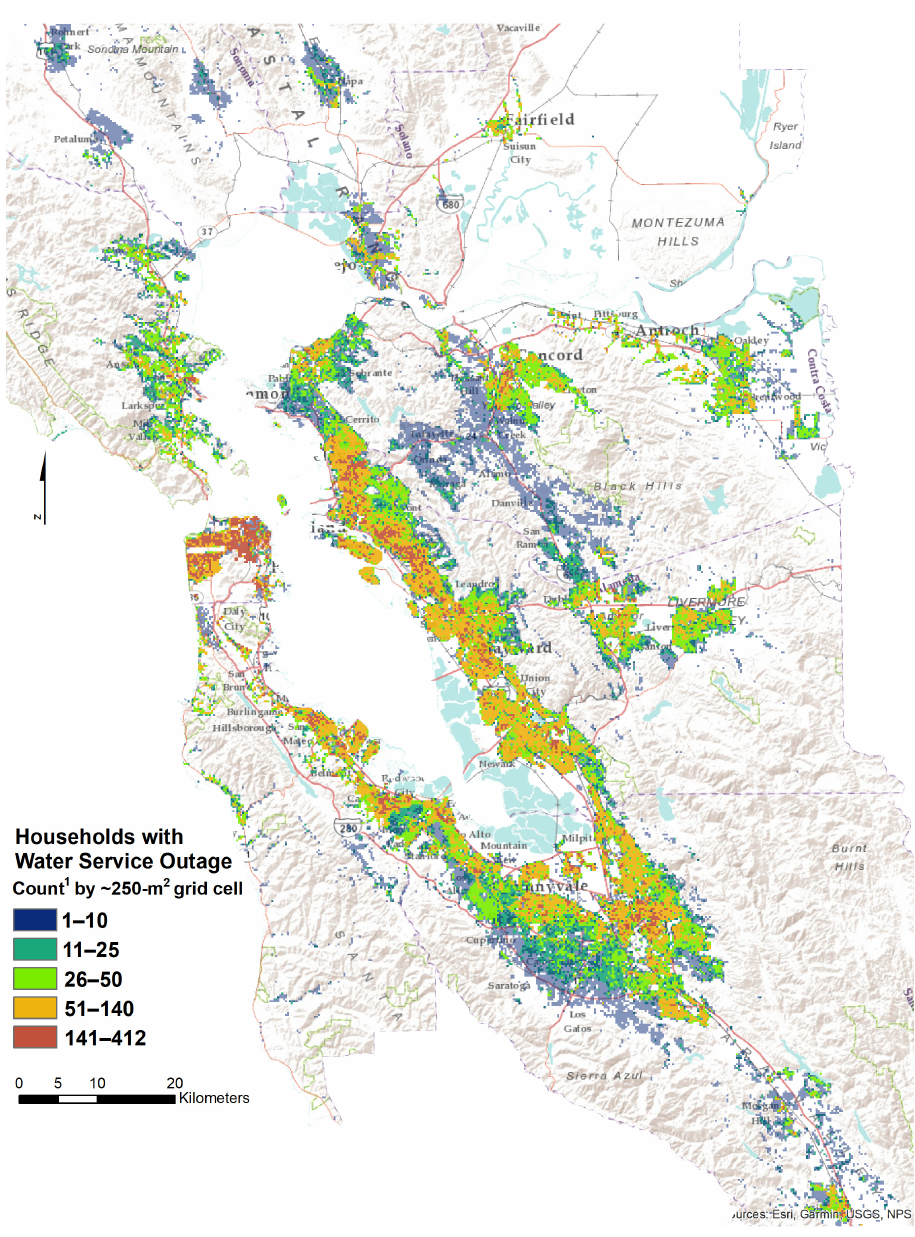
Figure 9. Estimated households with potable water service outage. 1 Grid cells with less than 1 household (~2.69 residents) have been excluded from display.